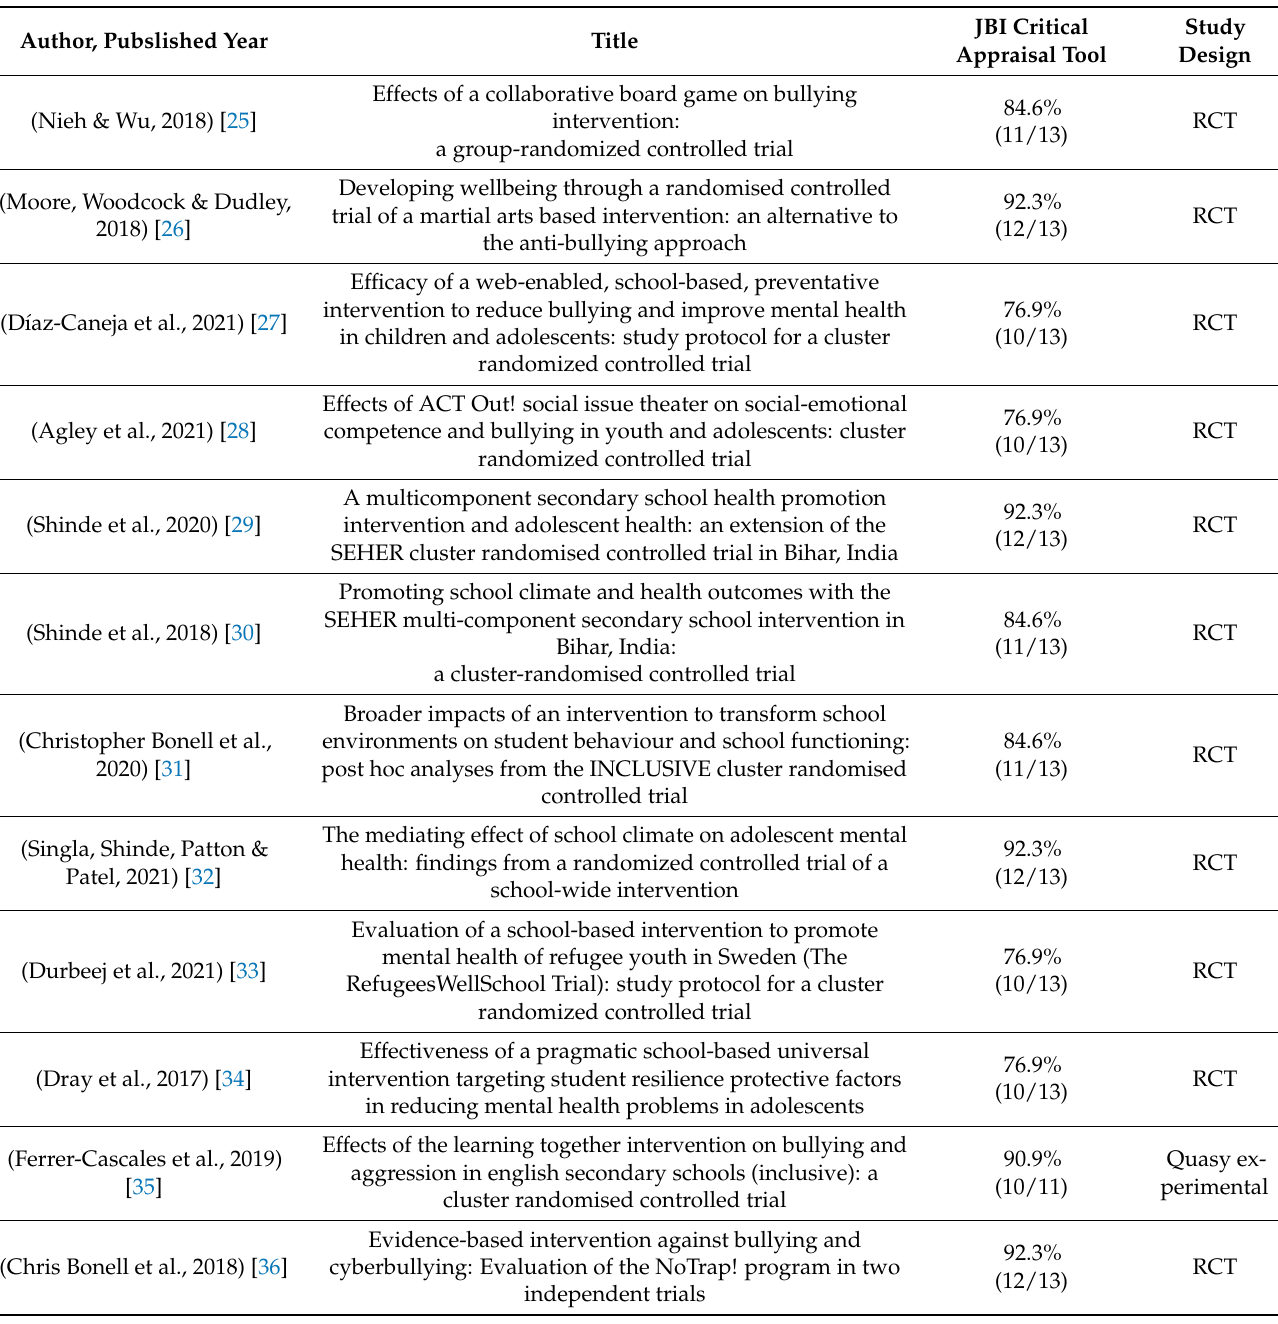
Table 1. JBI Critical Appraisal